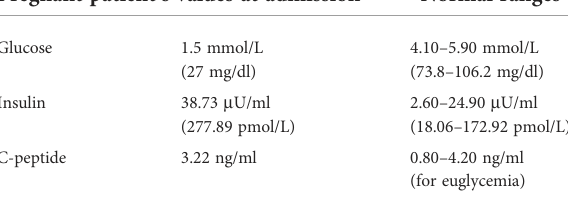
TABLE 2 Pregnant patient ’ s values of glucose homeostasis at admission. Pregnant patient ’ s values at admission Normal ranges